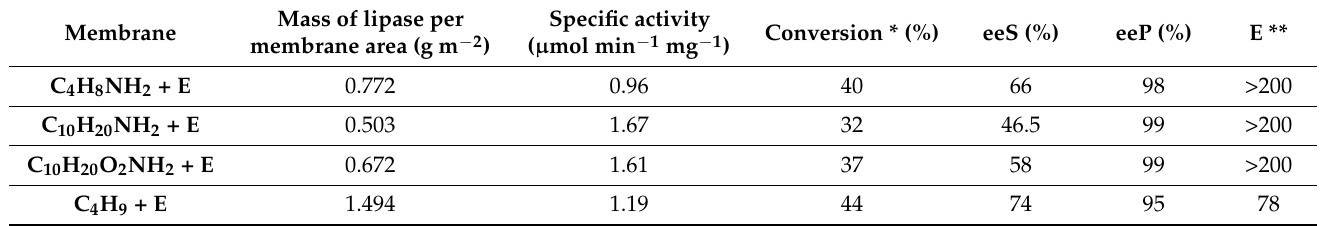
Table 4. Candida antarctica type B (CALB) lipase immobilized membranes’ performance in transesterification of ( R,S )-1- phenylethanol with vinyl acetate. Enzyme immobilization strategy—covalent bonding—C 4 H 8 NH 2 + E, C 10 H 20 NH 2 +